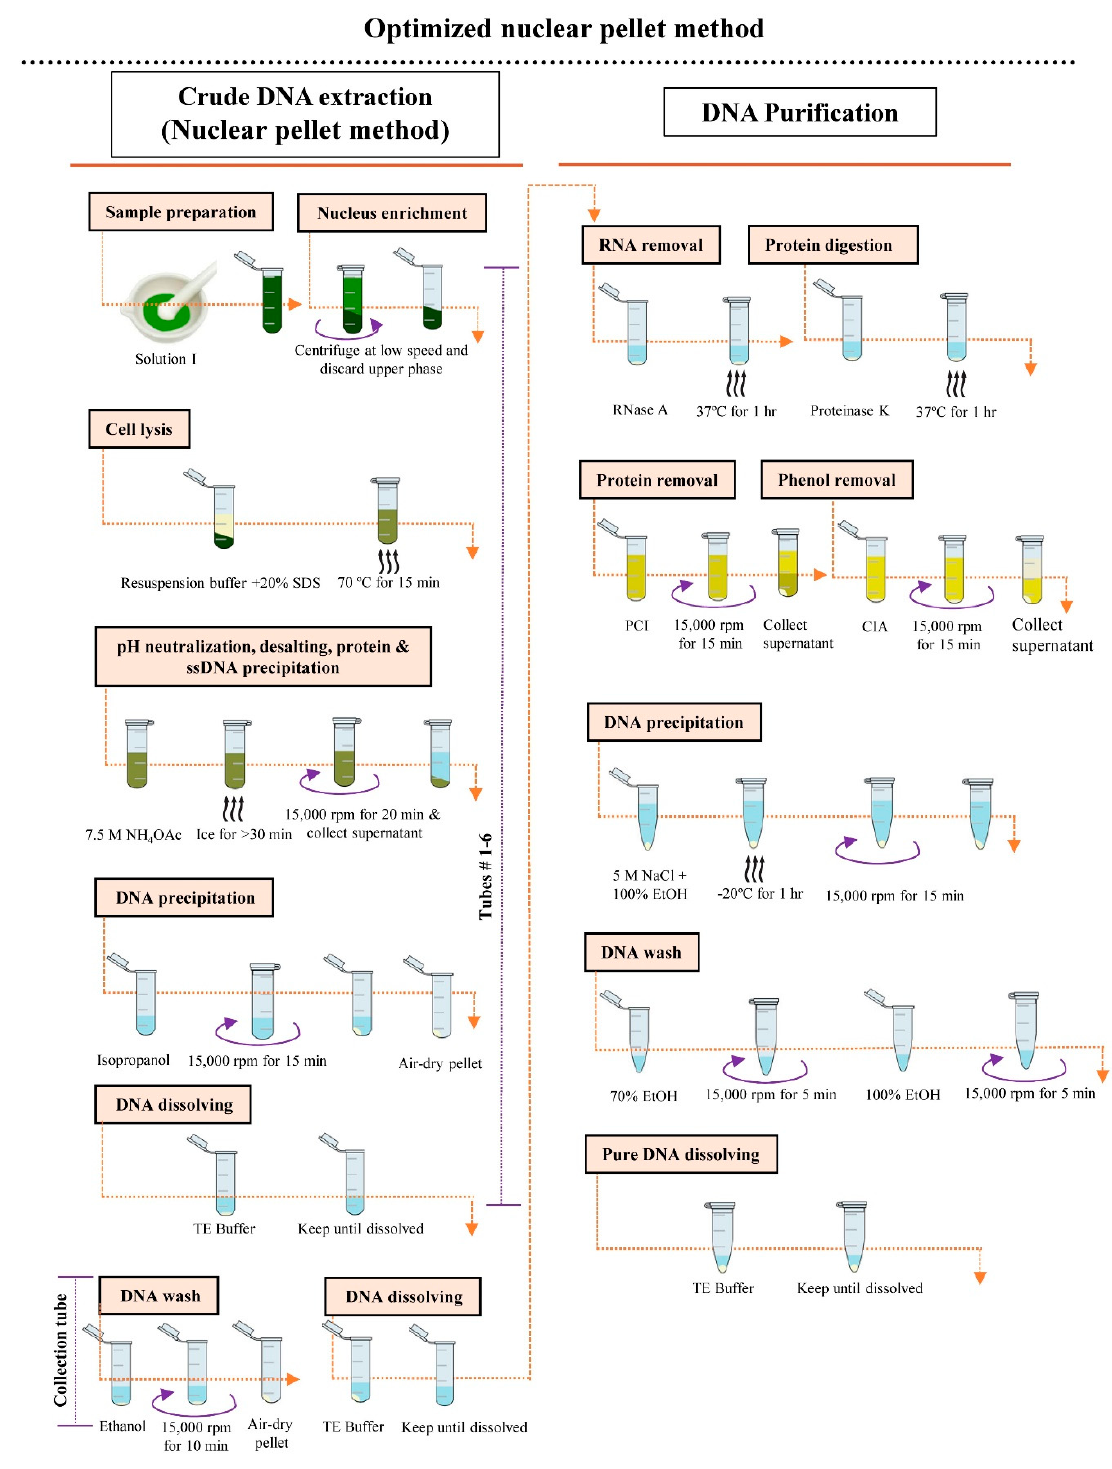
Figure 1. Schematic illustration of the procedures of genomic DNA extraction using the optimized nuclear pellet (NP) method. nuclear pellet (NP)